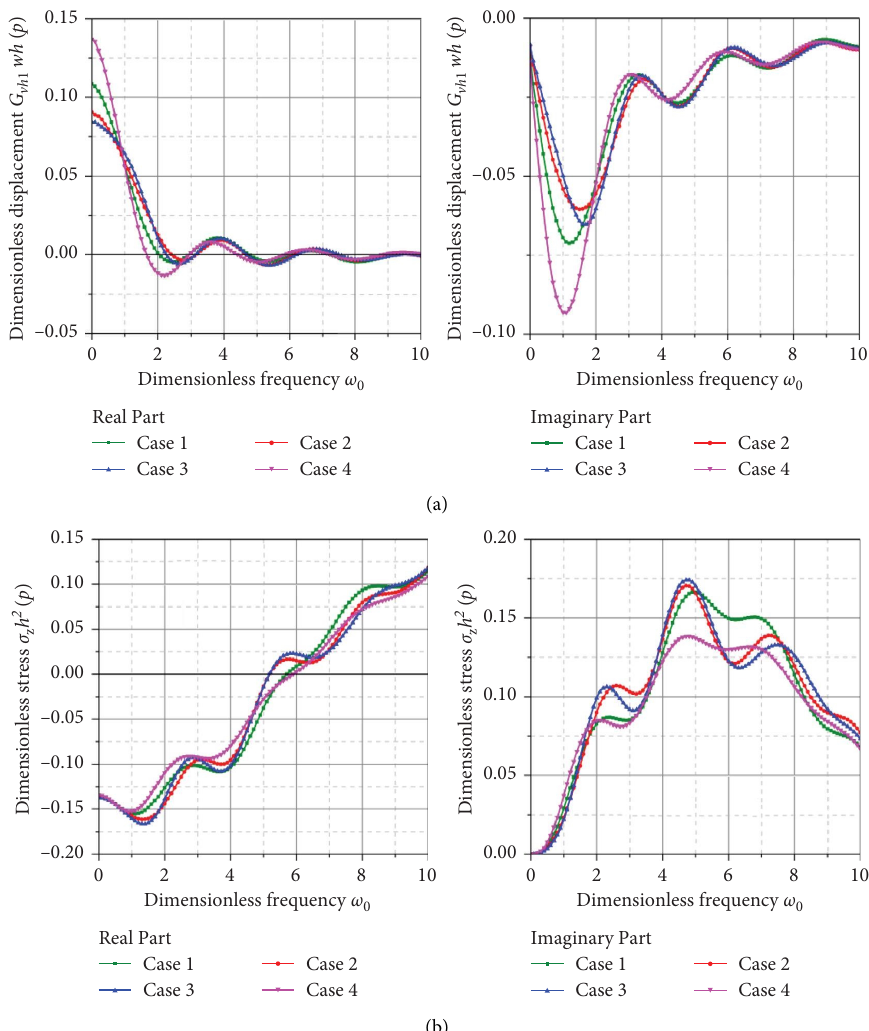
Figure 16: Te real and imaginary parts of (a) the vertical displacement and (b) the vertical stress at a fxed surface point ( r , θ , z ) � ( h , 0, 0) for the diferent cases versus the dimensionless